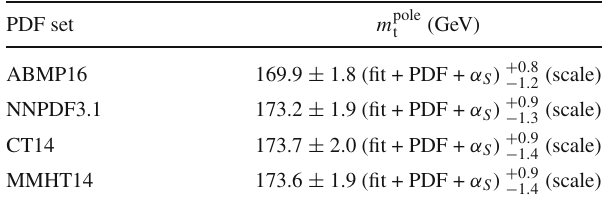
Table 7 Values of m pole t obtained by comparing the with predictions at NNLO+NNLL using different PDF sets PDF